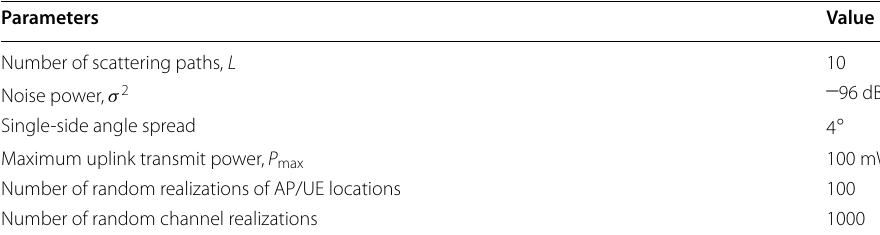
Table 3 Parameters setup